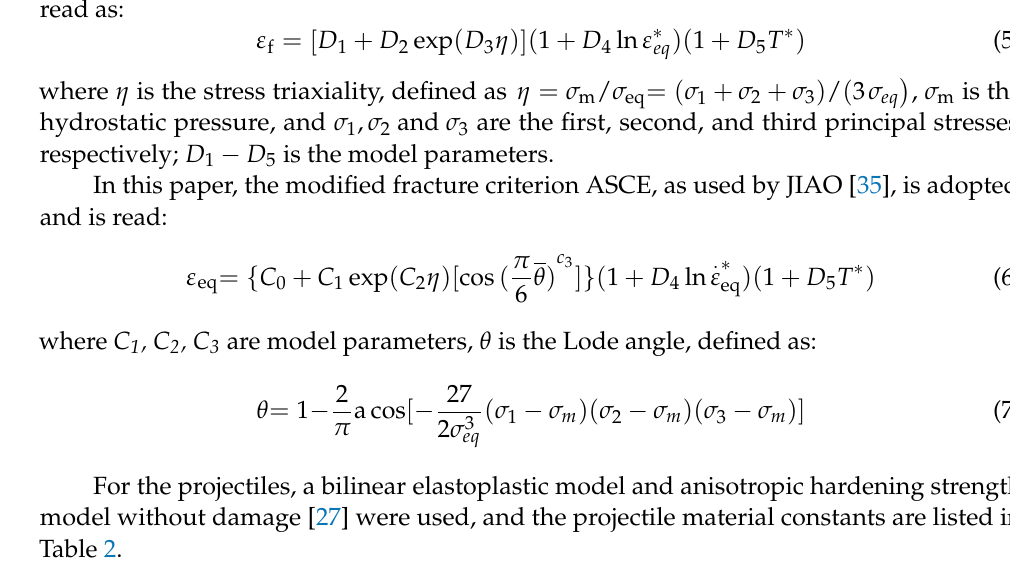
Table 2. The material parameters of the blunt